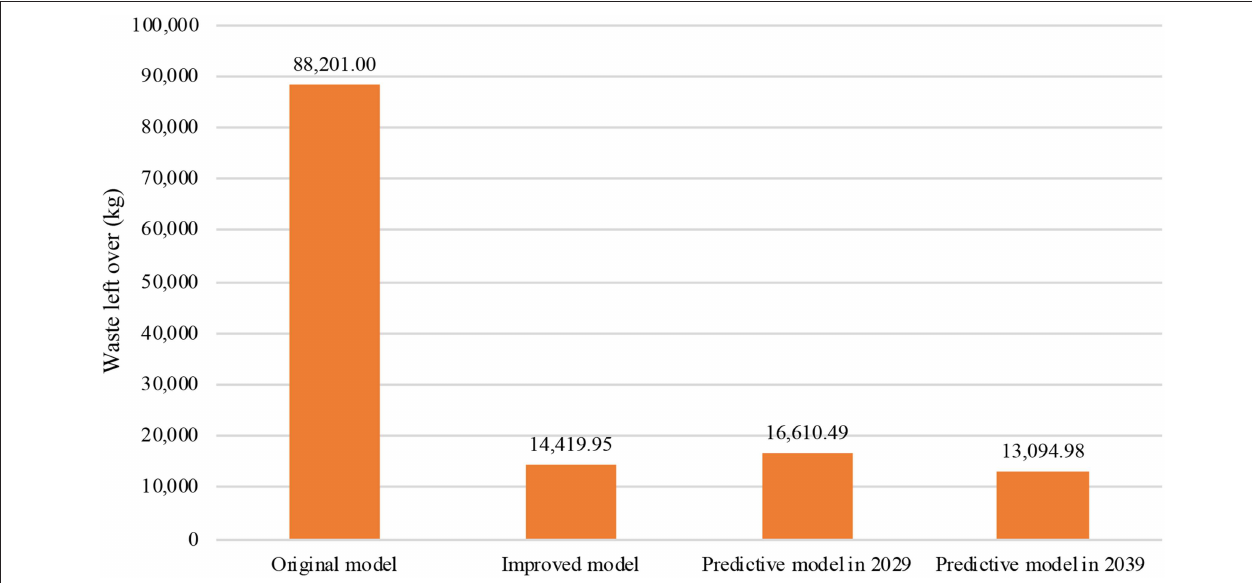
Frontiers in Built Environment |